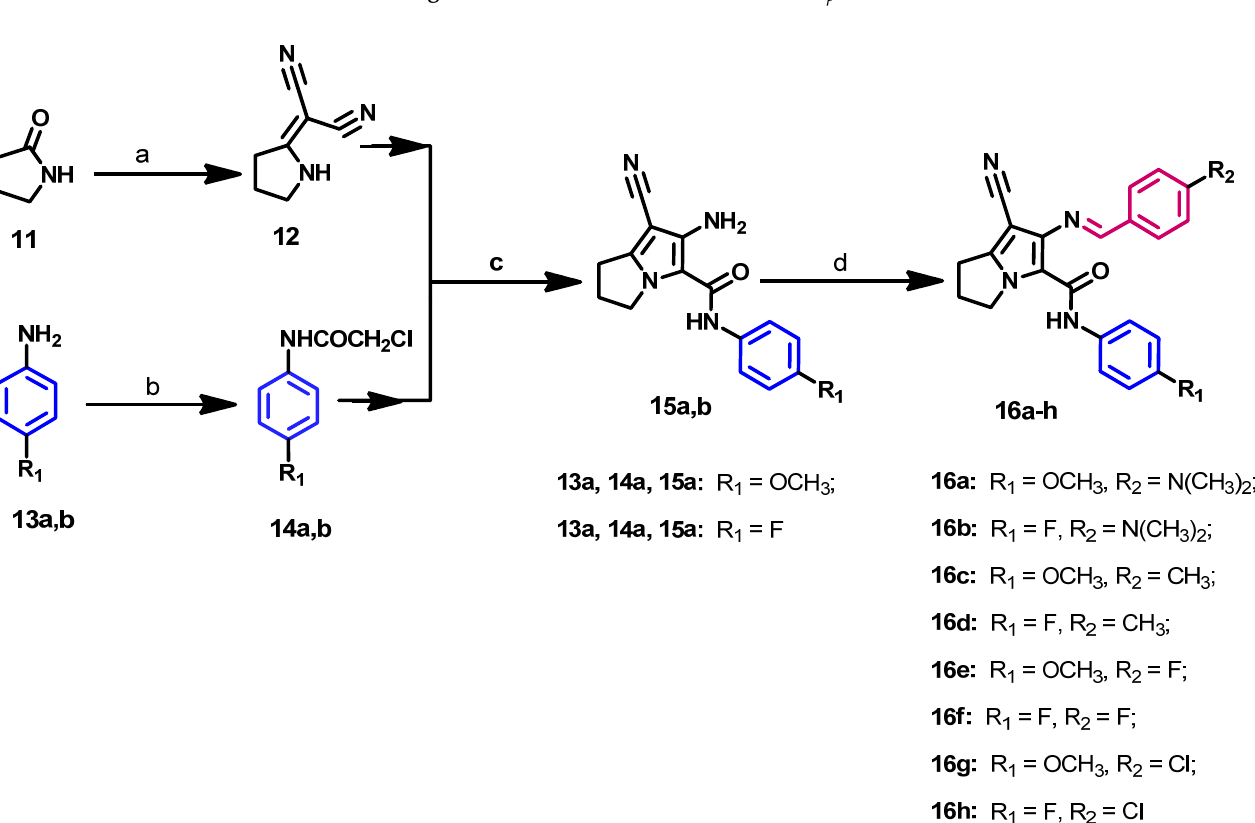
Figure 9. Structural modifications of hits 1 p .